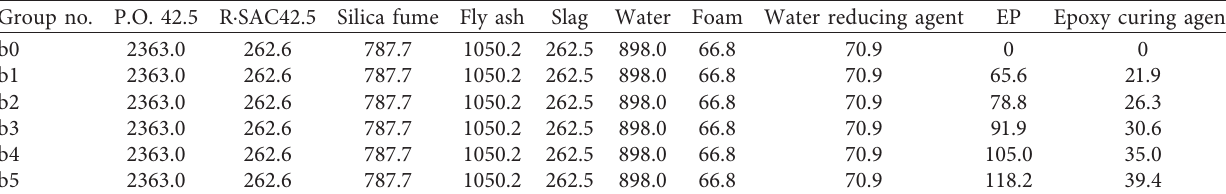
Table 3: Composition of FC specimens (kg/m 3